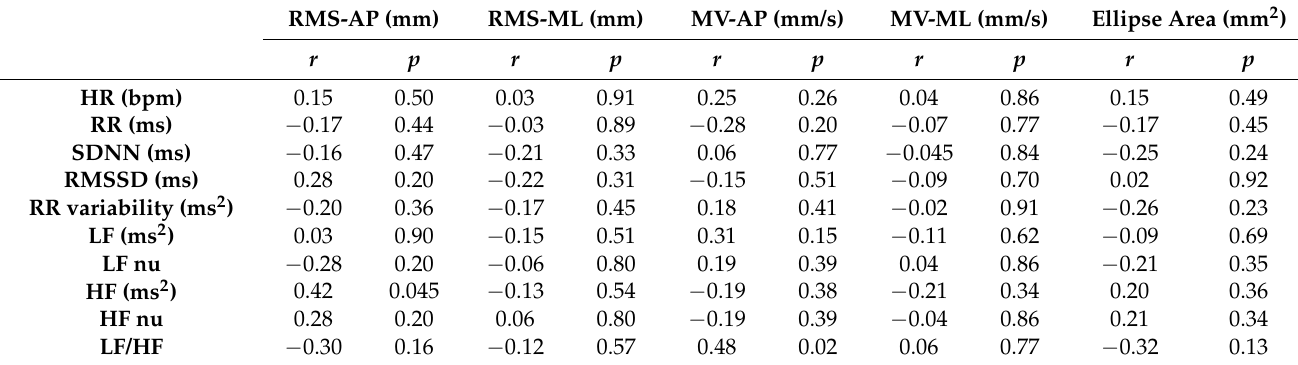
Figure 2. Frequency domain heart rate variability indices assessed at supine and standing postures. HF: high frequency; LF: low frequency; nu: normalized unit. Table 4. Correlation between indices of heart rate variability in the supine position with stabilometric variables of the center of